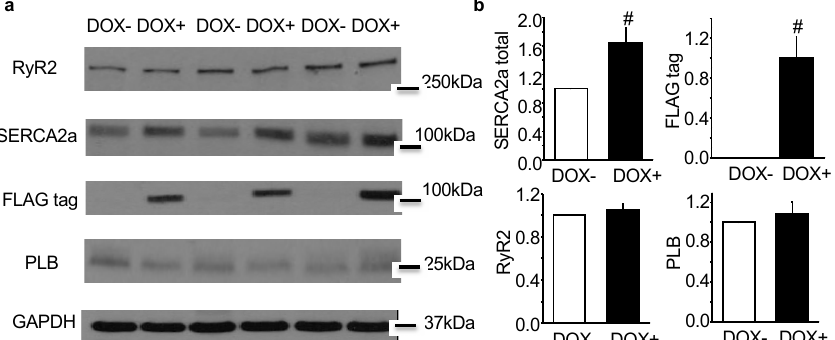
Figure 1. Representative western blot results ( a ) and the corresponding protein quantifications ( b ) for SERCA2a total, FLAG tag, RyR2 and PLB. Protein expression (indicated by the intensity of the band) in the DOX + group was normalized to the paired DOX- group. 40 µ g of protein lysate was loaded for each lane. Data are mean ± SEM; # p < 0.05 vs. DOX − .